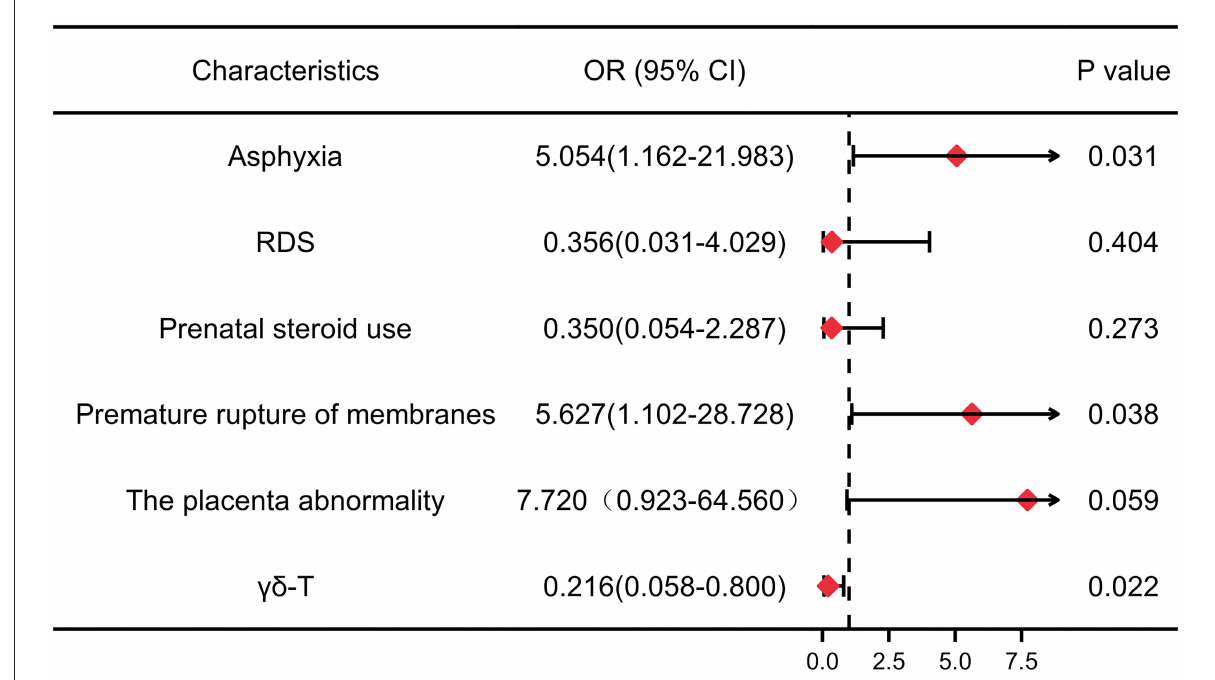
FIGURE4 Forest plots for meta-analyses of adjusted odds ratios depicting the strength of association between risk factors and cPVL. The red rhombuses represent OR, and the horizon lines represent 95% confidence intervals. P < 0.05 was considered significant. OR: odds ratio. 95% CI, 95% confidence interval. RDS, respiratory distress syndrome.